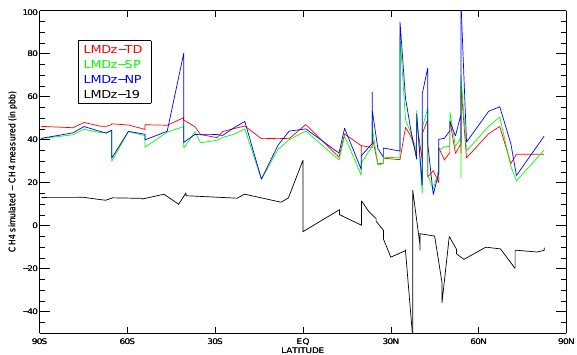
Figure 2. Latitudinal distribution of the bias between simulated methane mixing ratio using an optimized flux distribution coming from a satellite-based inversion and methane mixing ratio measured at different surface